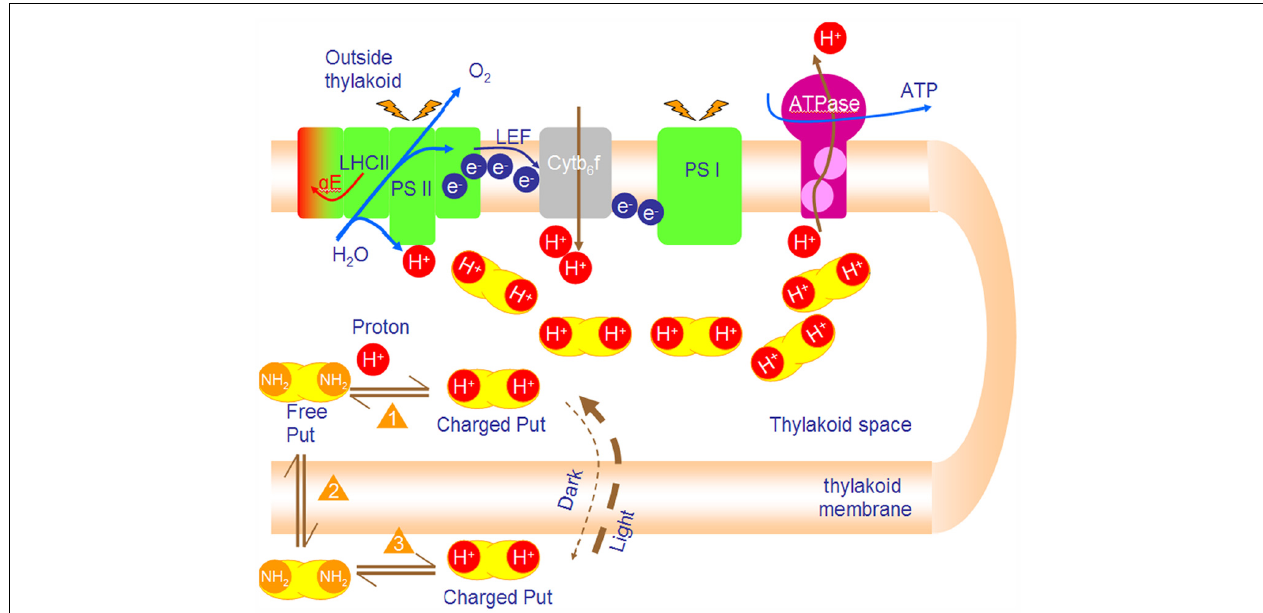
equilibrium 2). Finally, free Put in stroma is replaced by charged Put in stroma which is ionized (equilibrium 3).The net result of this process (i.e., new poise of the 3 equilibria) is ion trapping.That is the accumulation of Put in lumen up to 100 times.The final concentration of Put depends mainly on (cid:2) pH and counterion concentration (such as Cl − ).